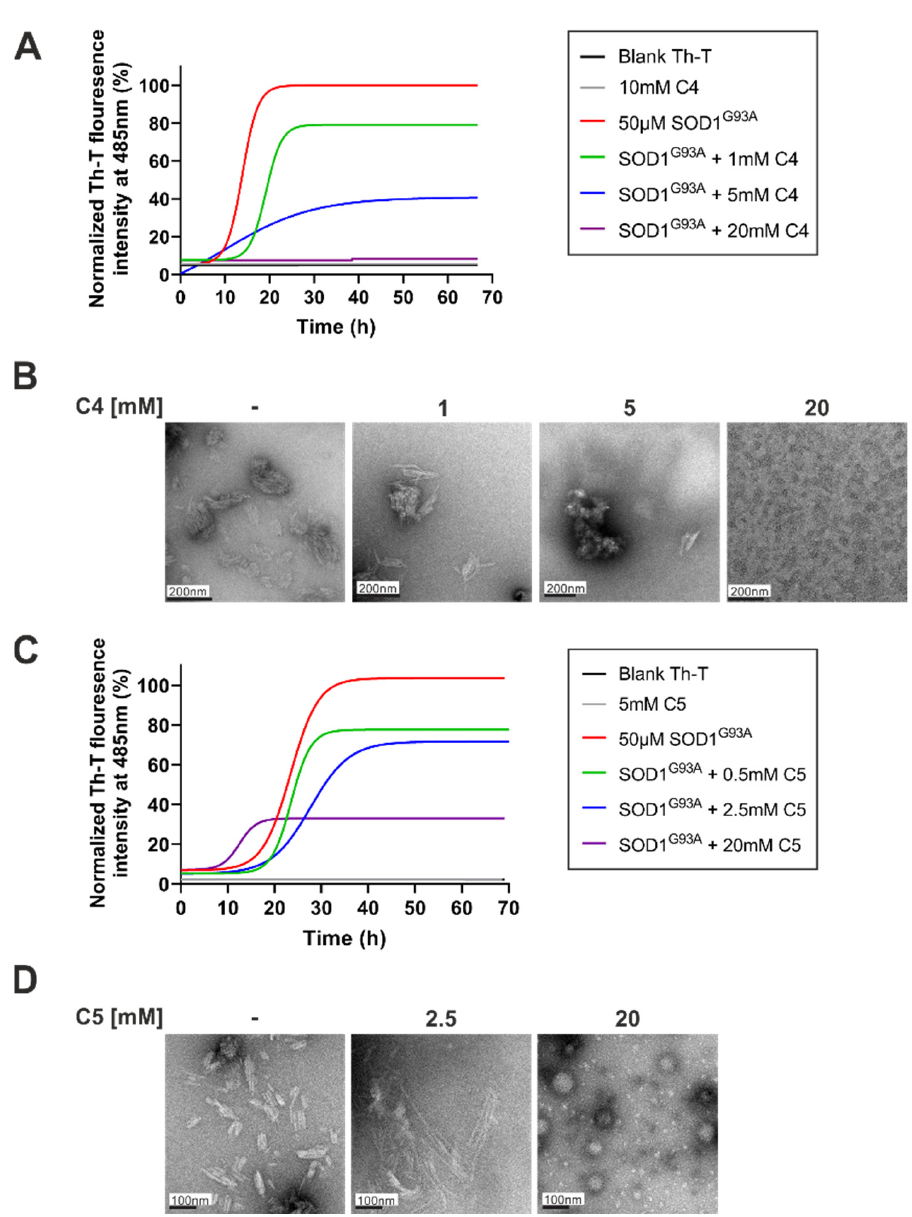
Figure 2. C4 and C5 strongly inhibited the formation of SOD1 G93A amyloid aggregation in vitro. ( A , C ) Recombinant SOD1 G93A amyloid aggregation was determined by monitoring Th-T fluorescence intensity during co-incubation of SOD1 G93A solution (50 µM) with different molar ratios of C4 (1–20 mM, ( A )) or C5 (0.5–20 mM, ( C )) at 37 °C for ~70 h. Fluorescence was normalized to the maximal Th-T fluorescence intensity elucidated by SOD1 G93A alone. Data points represent the average results from one representative experiment (performed in triplicates) of three independent experiments. Fluorescence was fitted to the Boltzmann sigmoidal equation using GraphPad Prism software. ( B , D ) TEM images of SOD1 G93A solution (50 µM) after 70 h incubation at 37 °C alone or with the presence of 1–20 mM of C4 ( B ) or 0.5–20 mM of C5 ( D ).